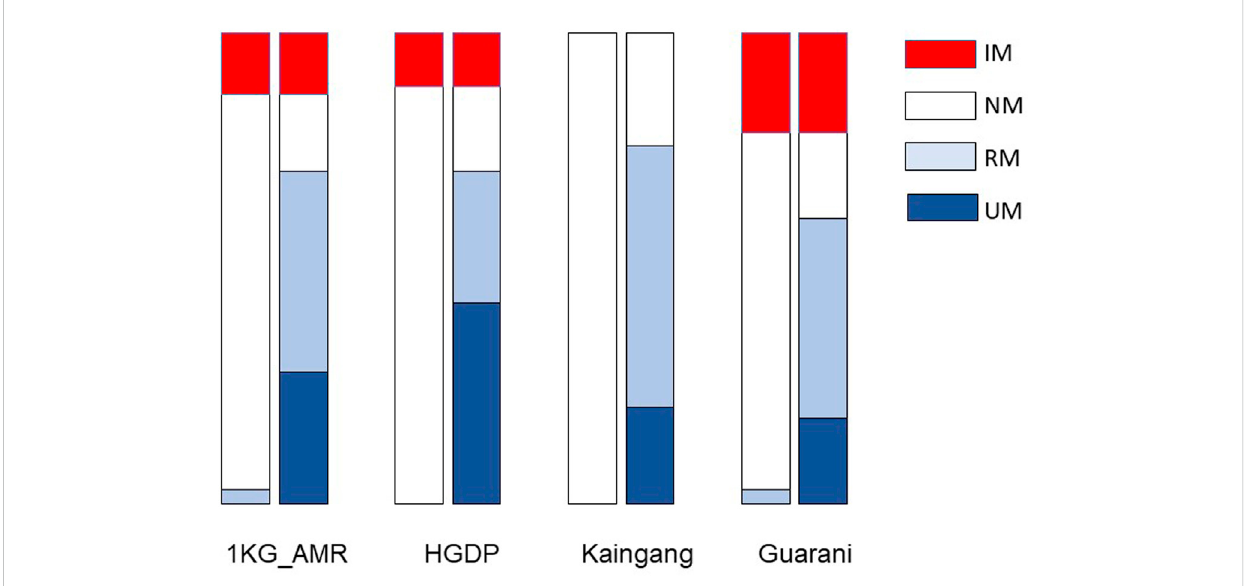
FIGURE 1 DistributionofpredictedCYP2C19metabolicphenotypesinthestudycohorts.Ineachpairofcolumns,theleftcolumnshowsphenotypeprediction based on CYP2C19 diplotypes (Table 2) and the right column shows phenotype prediction based on CYP2C19-CYP2C diplotypes (Table 3). The two assignmentproceduresresultedinhighlysigni fi cantdifferencesinphenotypedistributioninallcohorts(chi-square p < 0.0001).NM,normalmetabolizer; RM, rapid metabolizer; UM, ultrarapid metabolizer; IM intermediate